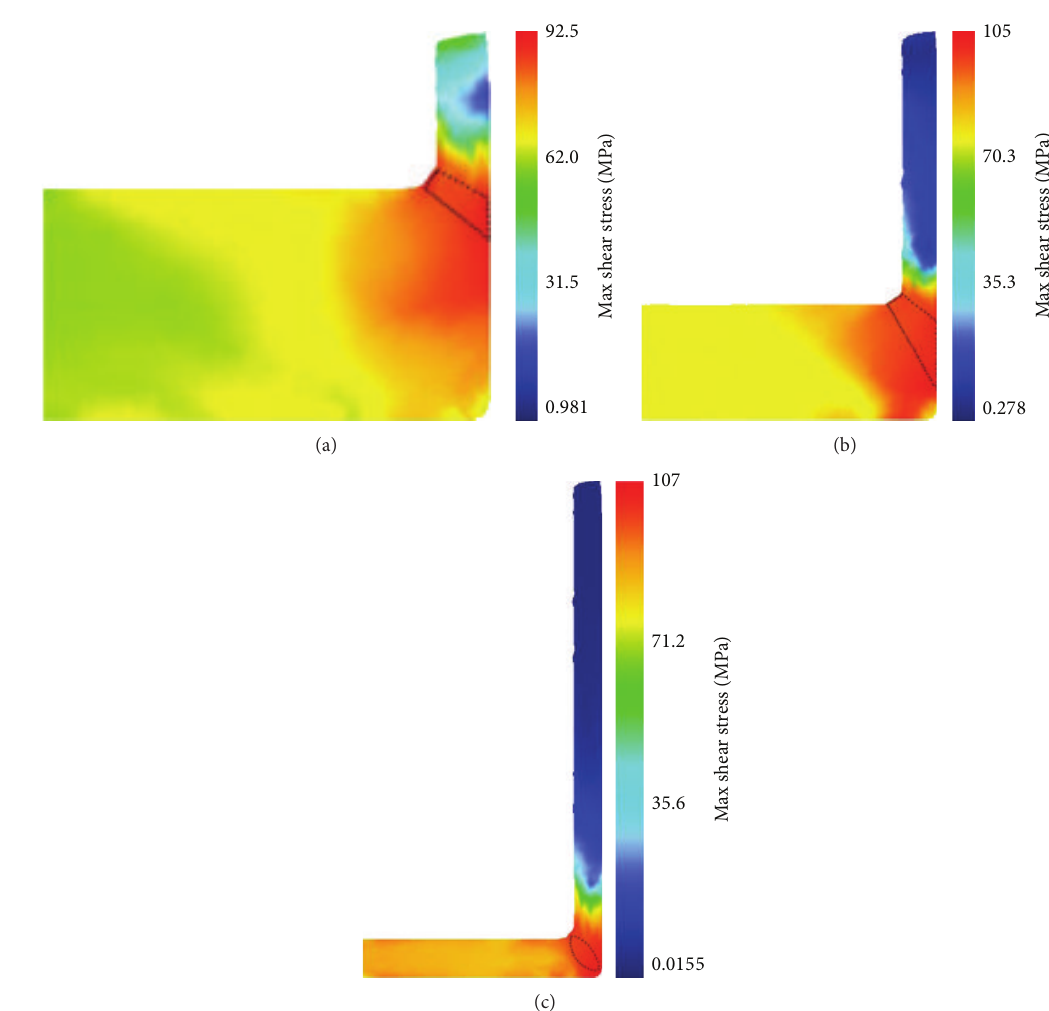
Figure 7: Max shear stress contours with different deformation: (a) Δ h = 5mm; (b) Δ h = 10mm; (c) Δ h = 20